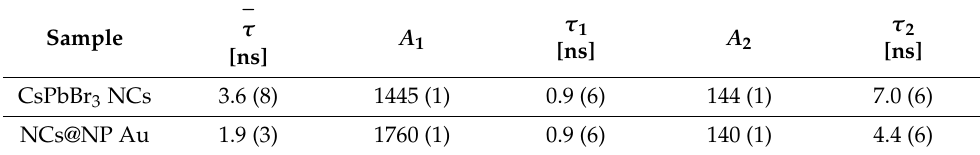
Table 4. Fit parameters of TR photoluminescence